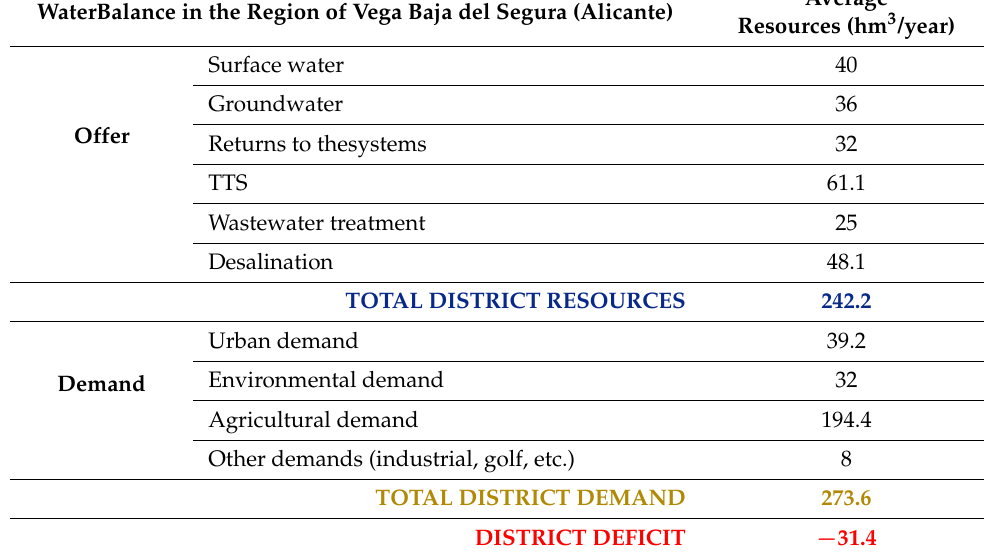
Table 8. Water balance 2021 in the region of Vega Baja del Segura (Alicante). WaterBalance in the Region of Vega Baja del Segura (Alicante)